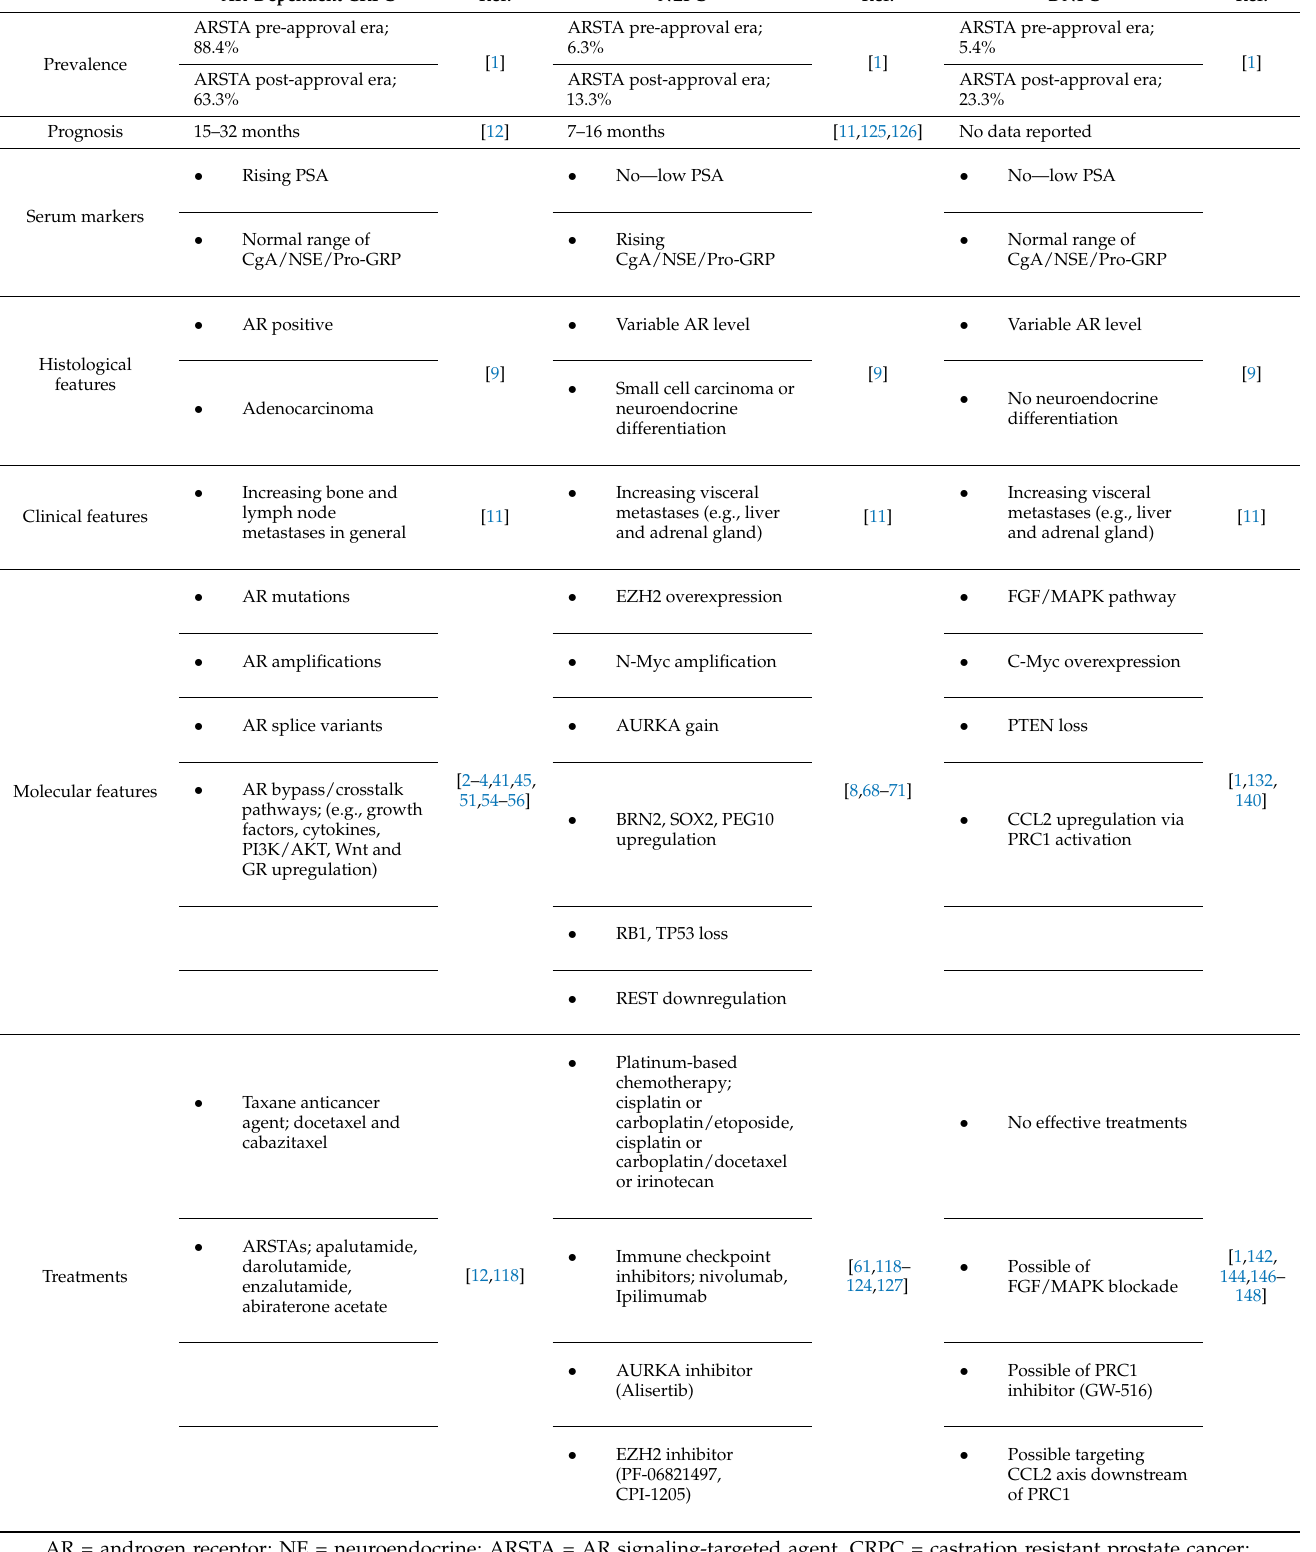
Table 1. Overview of three CRPC subsets; AR-dependent CRPC, NEPC, and DNPC. AR-Dependent CRPC Ref. NEPC Ref. DNPC